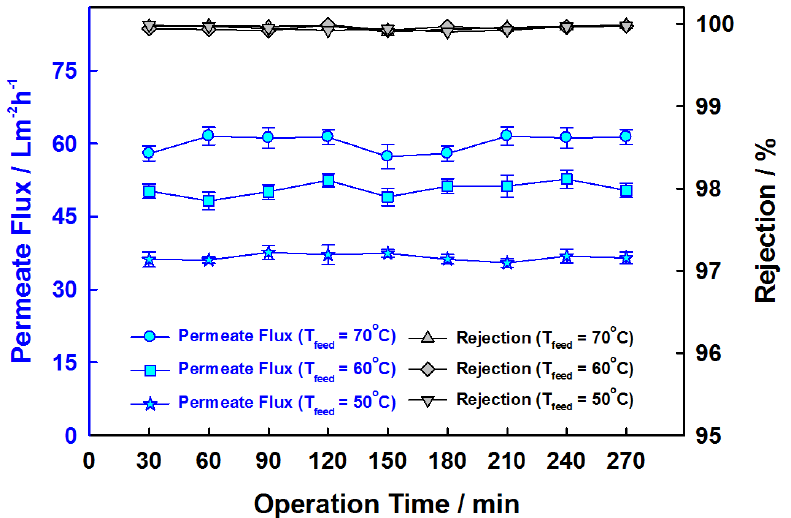
Figure 6. The performance of as-prepared hydrophobic hollow fiber sintered at 1400 °C with different feeding temperature (70, 60 and 50 °C) in VMD. Table 2. A list of the MD permeate flux values for ceramic membranes published recently. Configuration